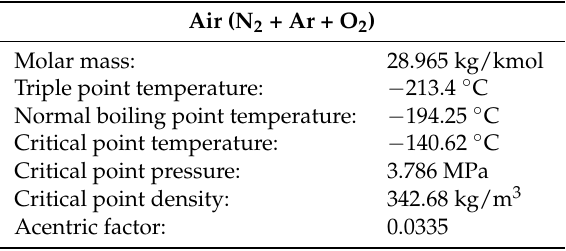
Table 3. The main properties of air used in numerical